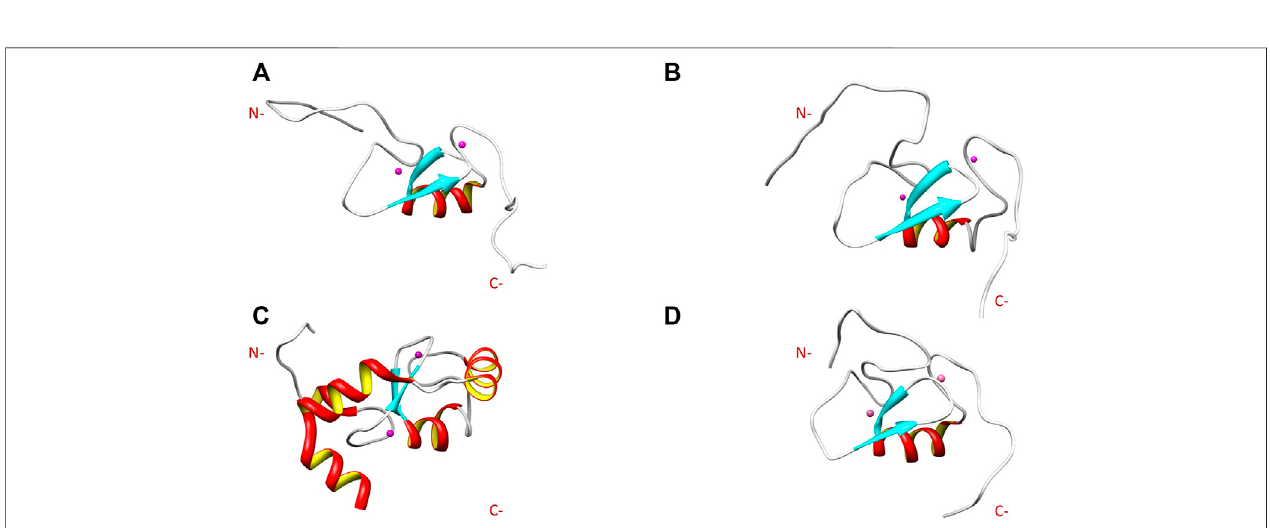
FIGURE 10 | Representation of β -sheets region in (A) wt and (B) R957C RING domain. (C) Overlay of the β -sheet region of wt (gold) and R957C mutant (white).